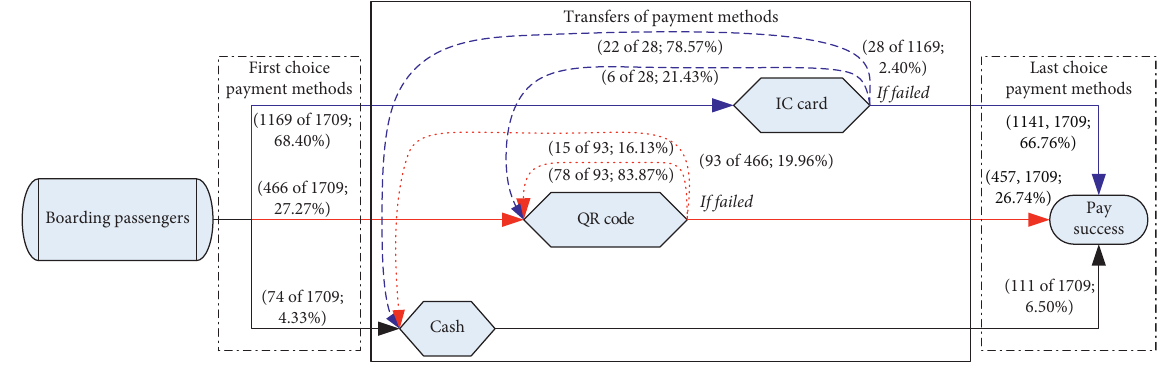
Figure 2: The share of different payment